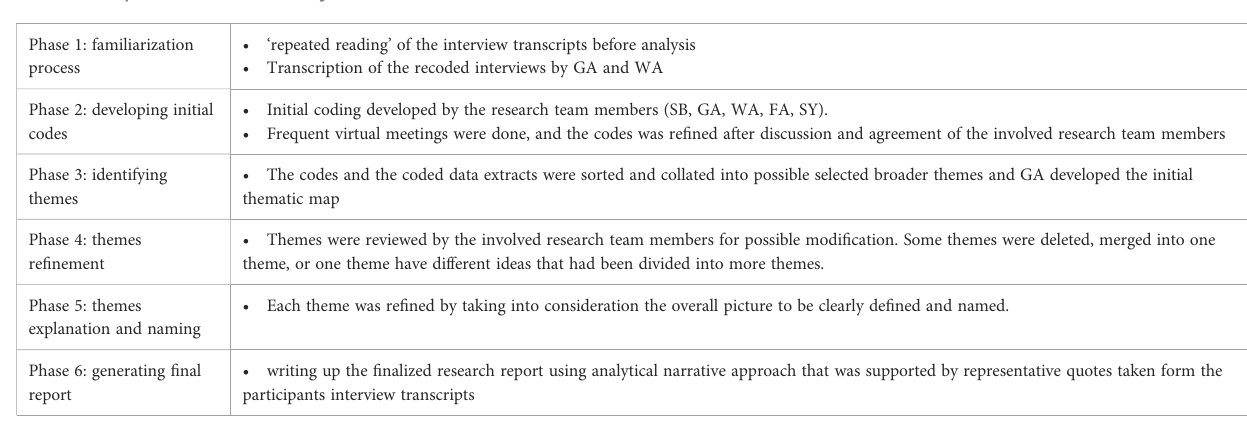
TABLE 1 Six phases of thematic